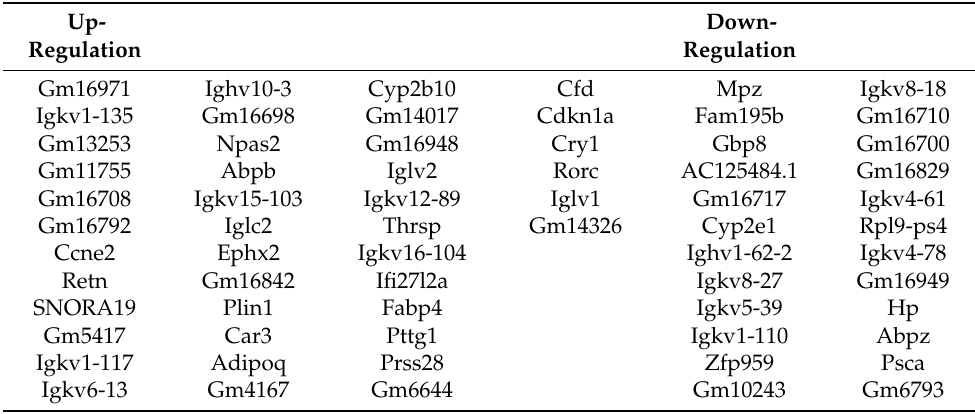
Table 1. A list of differentially expressed genes between PbsnCre+ ; Bmal1 fx/fx mice and Bmal1 fx/fx mice, as discovered using CAGE. Dorsolateral prostates of 20-week-old mice were analyzed ( N = 3 each).